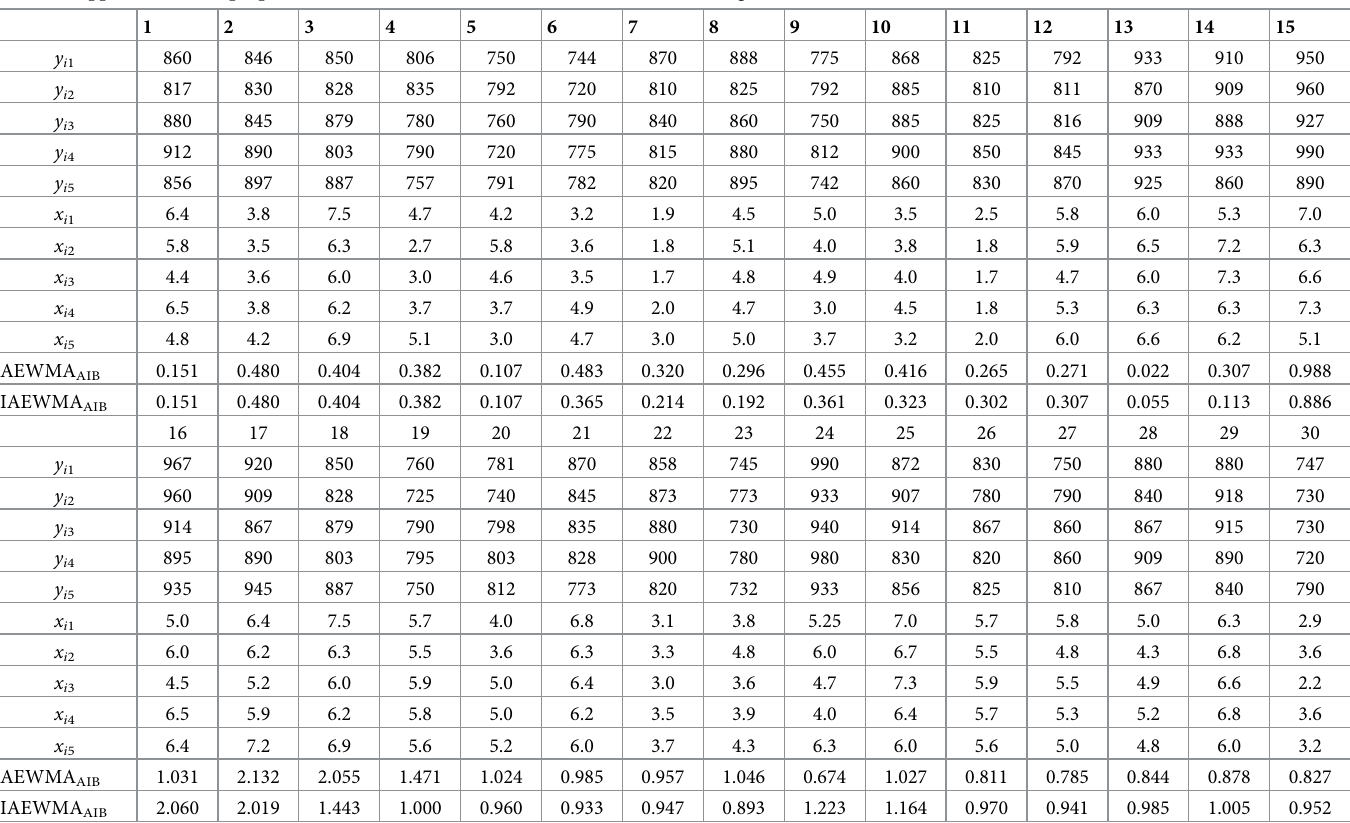
Table 8. Application of the proposed IAEWMA AIB versus AEWMA AIB control charts for ground water